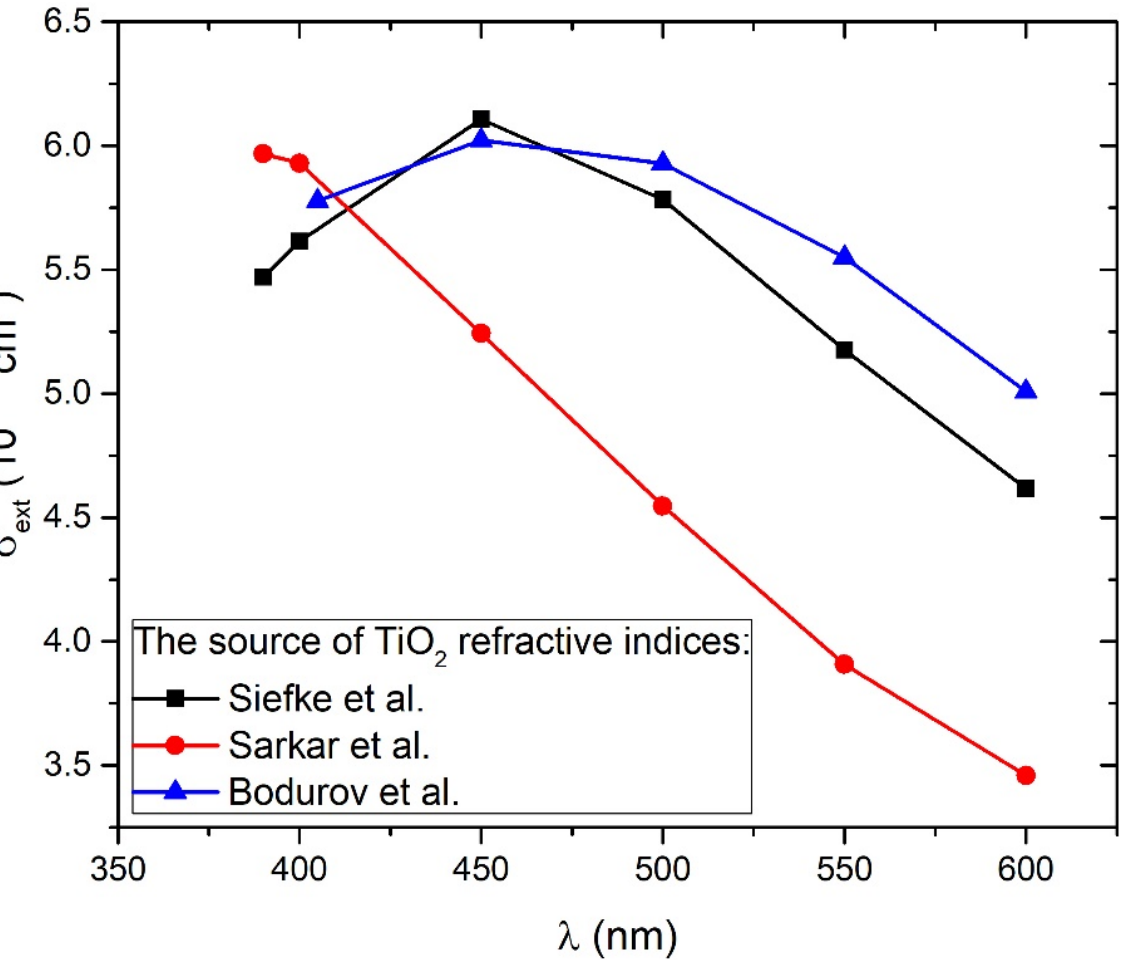
Figure 5. Extinction cross-section dependence on wavelength calculated from the Mie theory for TiO 2 solution of spherical nanoparticles using SEM size-distribution and TiO 2 refractive indices from three different works: Siefke et al. [51], Sarkar et al. [52], and Bodurov et al. [53,54] (listed on the website [55]).